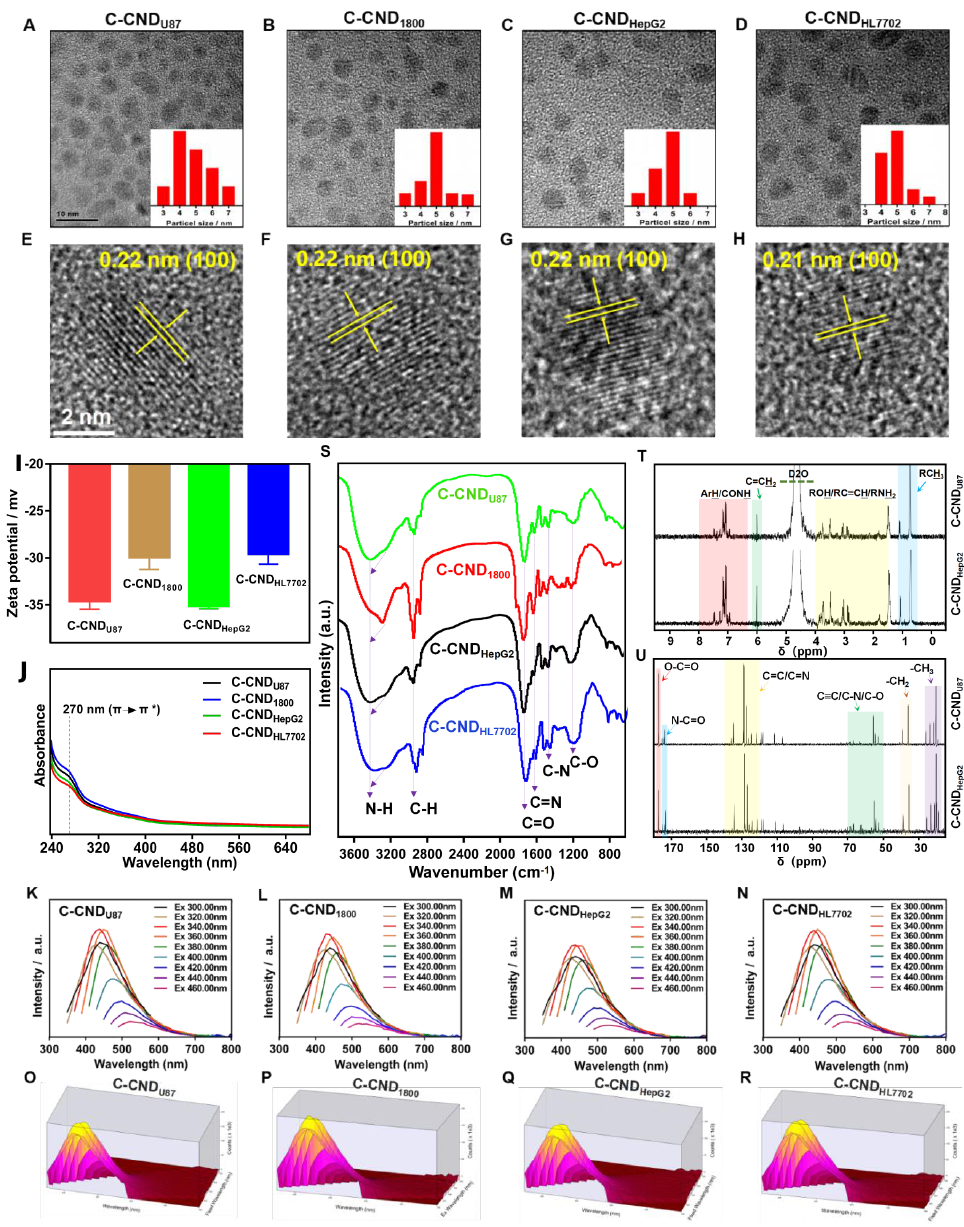
Figure 1. ( A − D ) TEM images (Bar = 10 nm), ( E − H ) HRTEM images (Bar = 2 nm), ( I ) Zeta potentials, ( J ) UV-vis spectra, ( K − R ) Excitation-dependent emission ( Em ) spectra, and ( S ) FTIR patterns of different C-CND. ( T ) 1 H-NMR and ( U ) 13 C-NMR spectra of C-CND U87 and C-CND HepG2 . Data are represented as mean ± SD ( n = 3). Yellow arrows: the d-spacing of